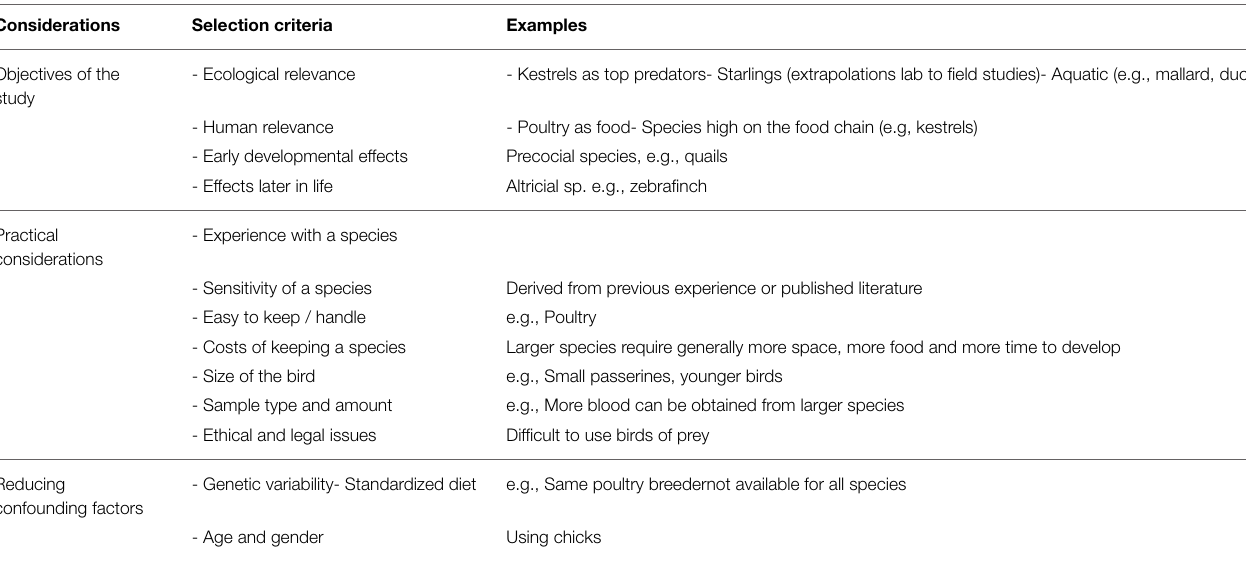
TABLE 1 | Considerations to be made when selecting the best bird model for ecotoxicological studies, in order of